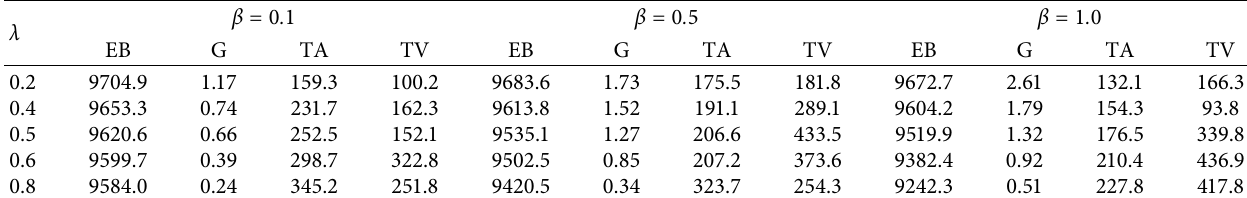
Figure 7: The Sioux Falls network. Table 3: Numerical results for the small